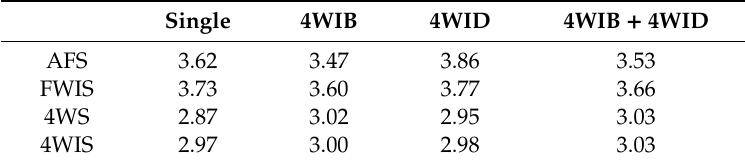
Table 5. Maximum absolute lateral o ff set errors for each actuator combination